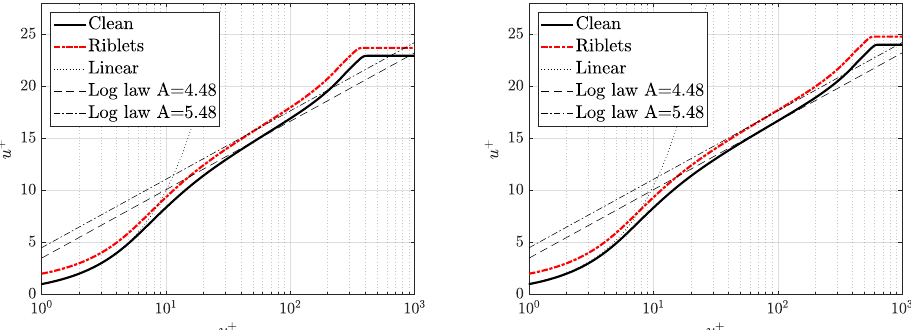
Figure 3. Mean velocity profile with/without riblets over the flat plate, at Re x = 5 × 10 5 ( left ) and Re x = 9 × 10 5 ( right ). The riblets profile consistently shows the upward shift of ∆ U + = 1 on the logarithmic